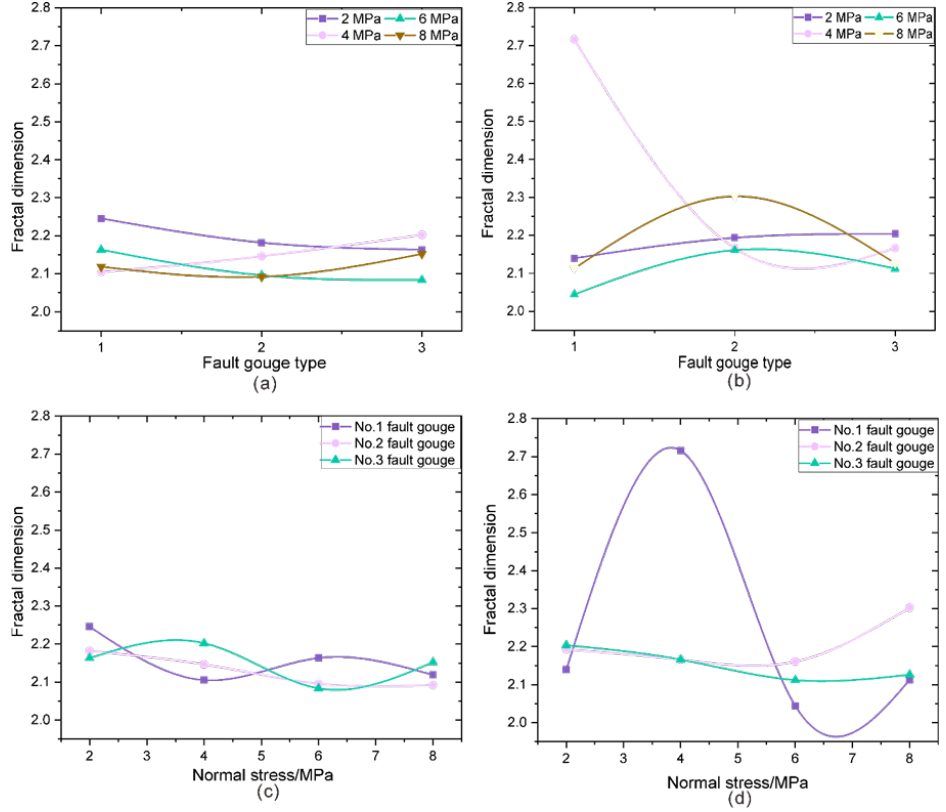
Figure 17. ( a ) The relationship between the fractal dimension of the shear fault and the type of fault gouge ( b ) The relationship between the fractal dimension of the tension fault and the type of fault gouge ( c ) The relationship between the fractal dimension of the shear fault and the normal stress ( d ) The relationship between the fractal dimension of the tension fault and the normal stress.